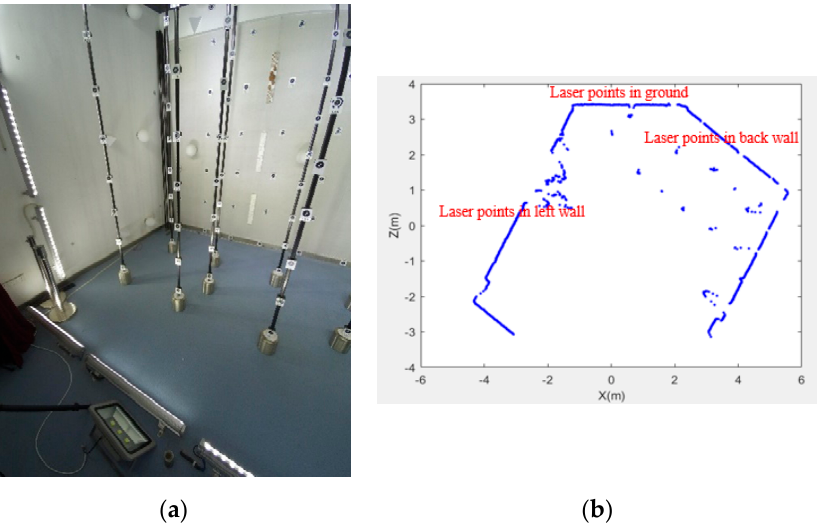
Figure 13. Image and range data for the extrinsic calibration between a camera and an LRF. ( a ) Image and ( b ) LRF range data.